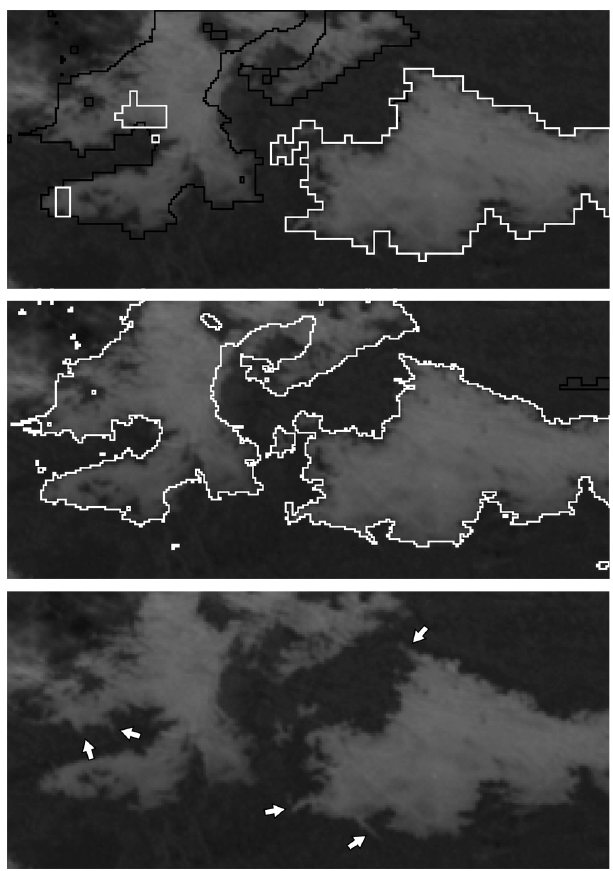
Fig. 9. 3km (top) and 1km (center) FLS mask for fog in Cen- tral Germany on 17 January 2011. White line = boundary of the 3km and 1km masks. Black line = boundary of an additional FLS mask based on channels interpolated to 1km resolution (Notice that this mask matches the 3km mask perfectly for the eastern FLS entity, which is why the black outline is not visible here). White arrows = details that strongly benefit from the resolution enhance- ment.